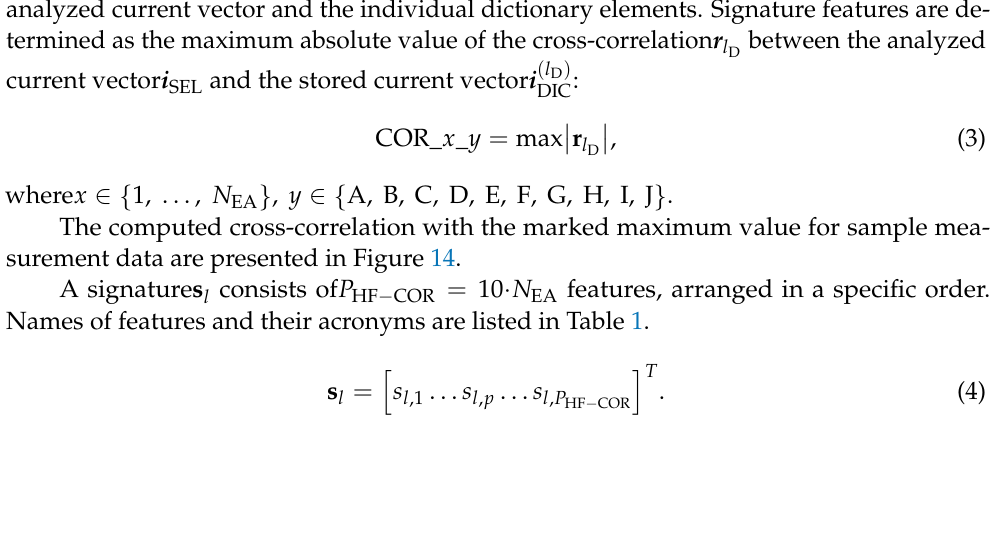
Figure 12. Cross-correlation as a function of delay for an example of the measurement data; the whole correlation vector ( a ); the fragment of the vector r that contains the highest correlation values ( b ).